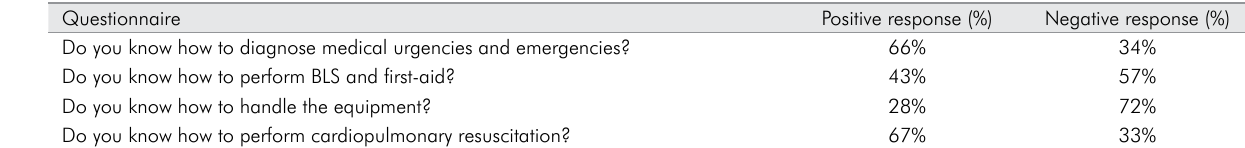
Table 1. Extent of BLS training of the dentists interviewed at the Hospital for Rehabilitation of Craniofacial Anomalies